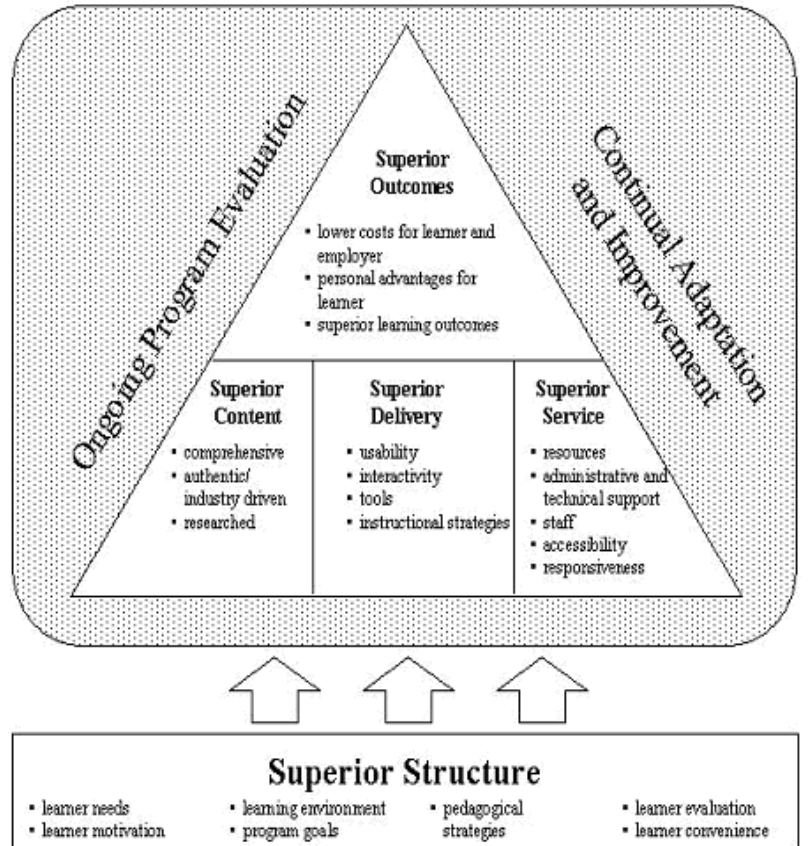
Figure 1. The Demand Driven Learning Model (DDLM) (MacDonald, C. J., Stodel, E., Farres, L., Breithaupt, K., and Gabriel, M. A. (2001). The demand driven learning model: A framework for Web-based learning. The Internet and Higher Education, 1 (4), 9 –